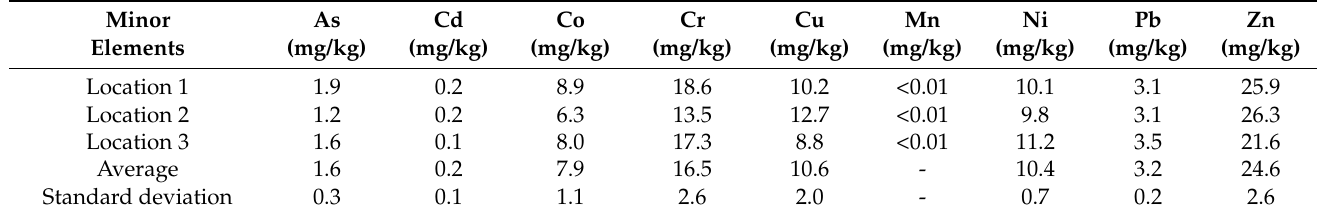
Table 5. Minor elements of A. altissima